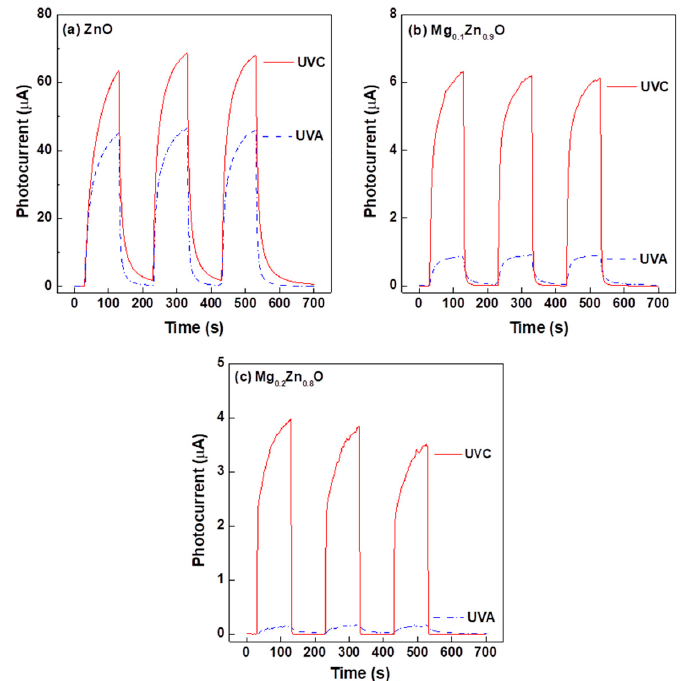
Figure 9. Time-dependent photoresponse of Mg x Zn 1 − x O photodetectors under UVA and UVC light illumination; the photodetectors had ( a ) ZnO, ( b ) Mg 0.1 Zn 0.9 O, and ( c ) Mg 0.2 Zn 0.8 O sensing layers. The applied bias voltage in the three kinds of devices was 5 V; the period of illumination was maintained at 100 s.